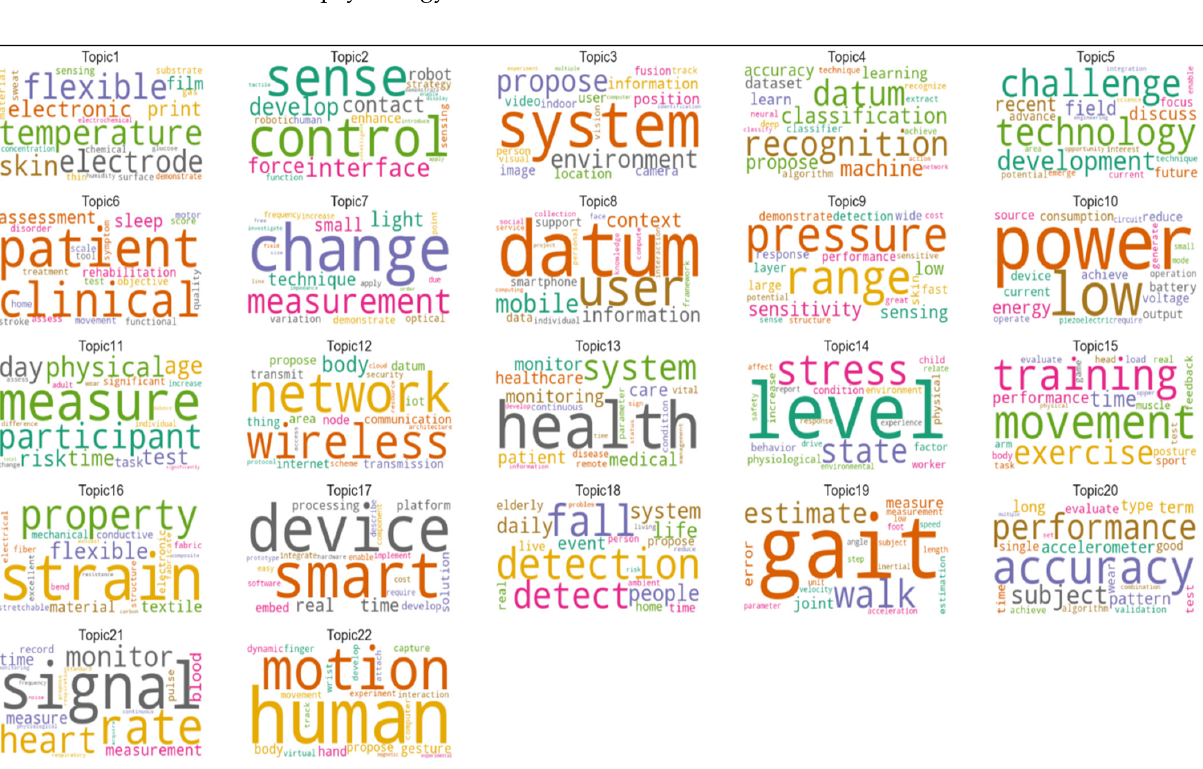
Figure 7. Word-Cloud in documents of wearable sensors.